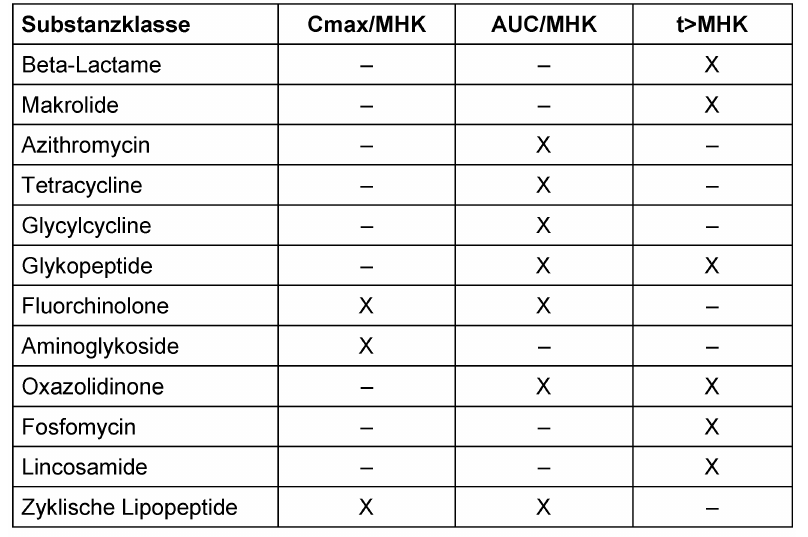
Tabelle 3: PK/PD Parameter von